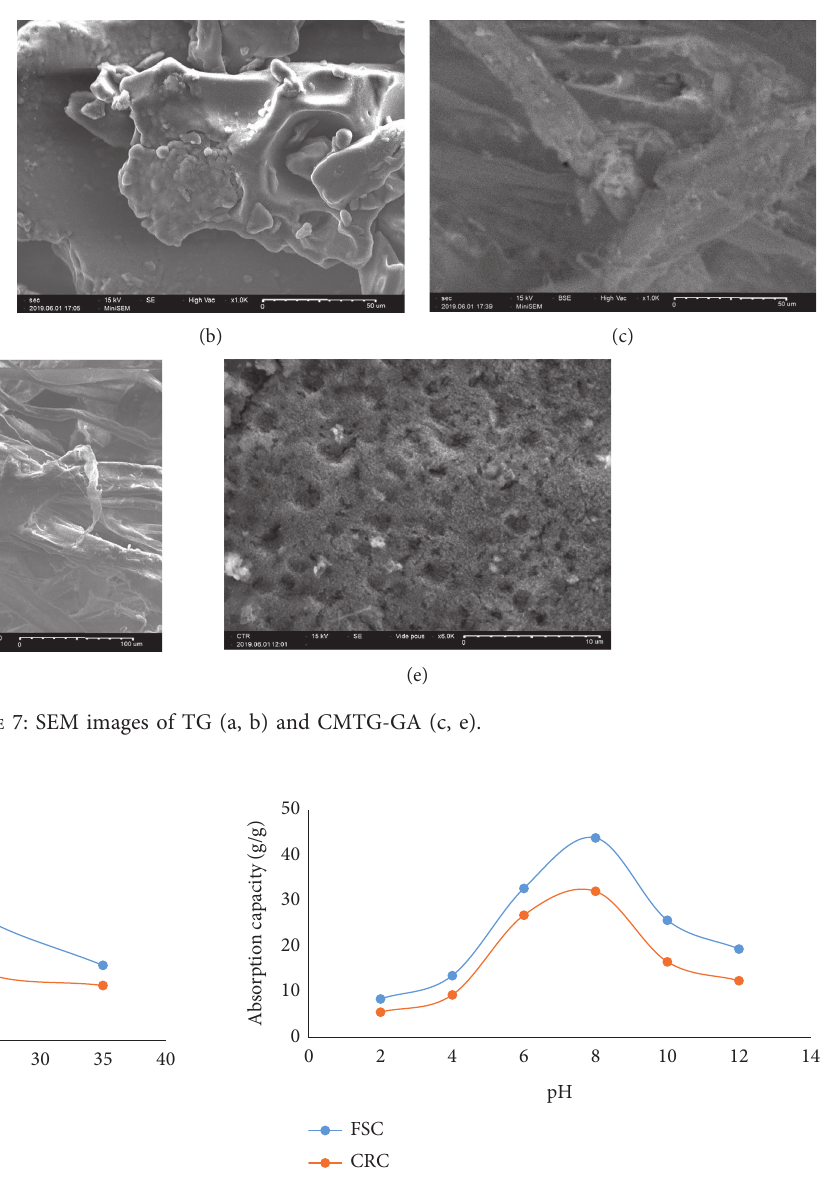
Figure 9: Effect of pH on the SAP